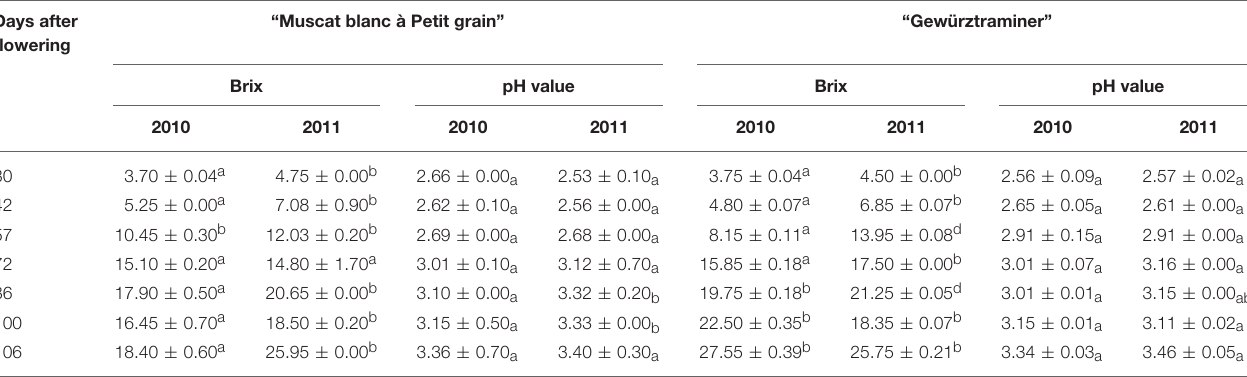
“Muscat blanc à Petit